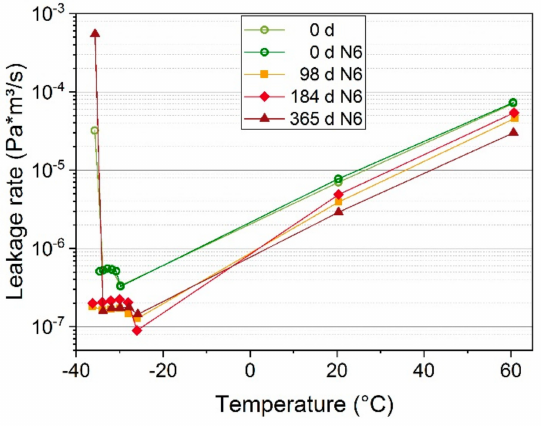
Figure 7. Leakage rate of an unaged seal and the seal N6 aged at 125 ◦